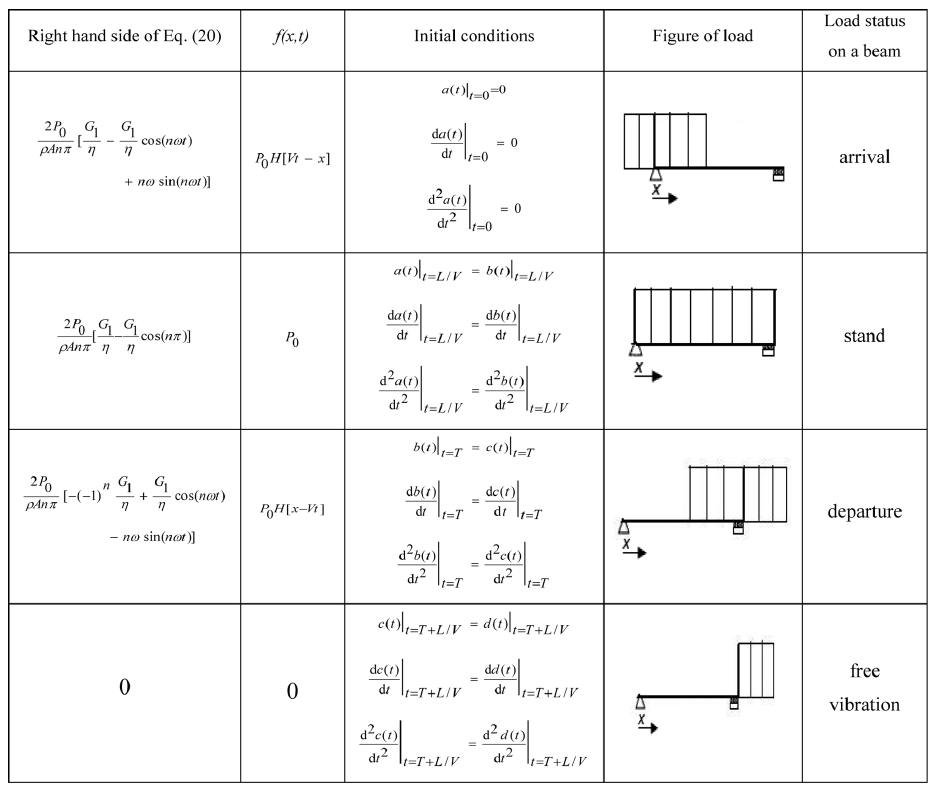
Table 1 Different forms of distributed loads on the